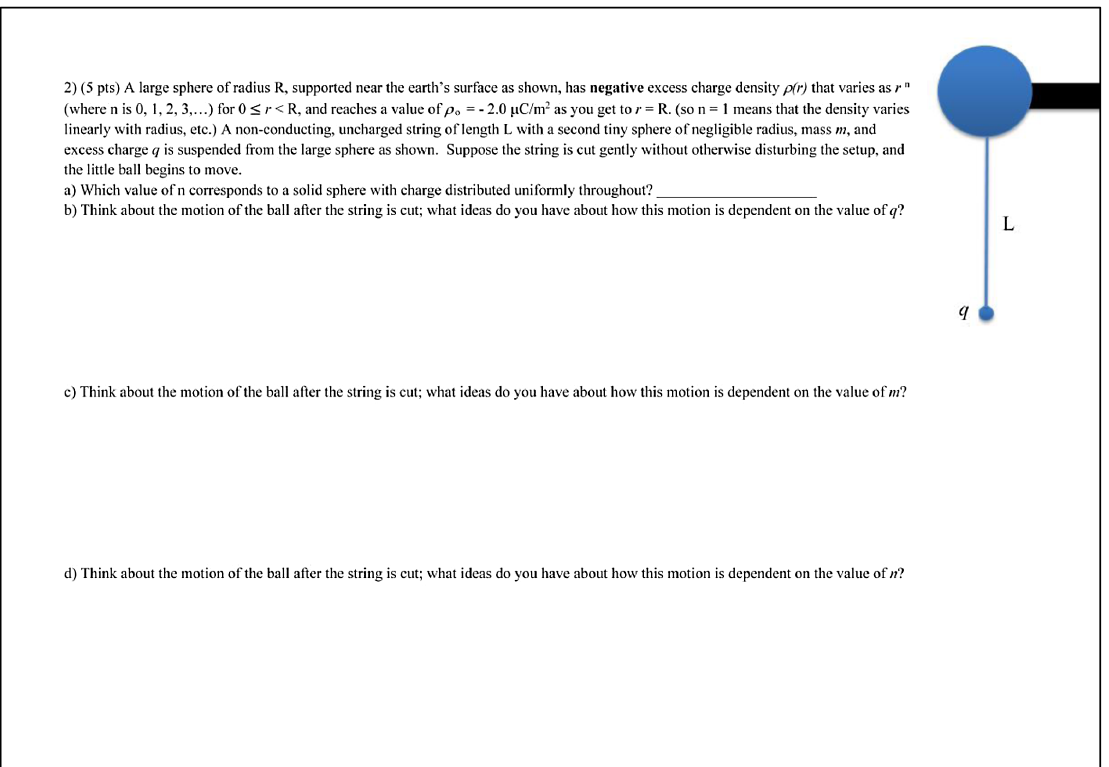
FIG. 16. Sphere with nonuniform charge density referenced in Fig. 10, layer 1 of